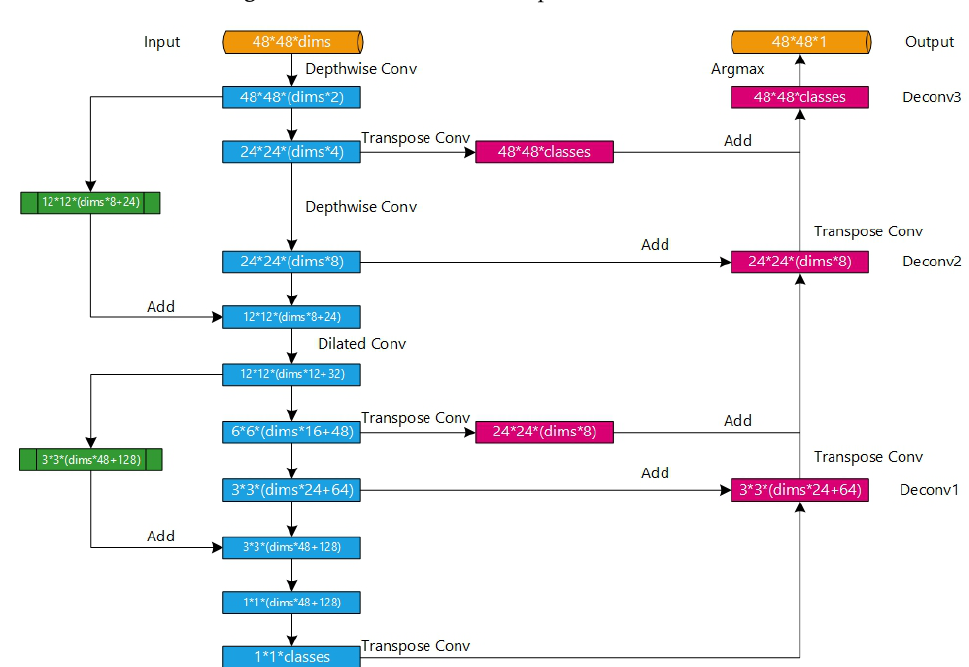
Figure 2. Structure of neural networks in our segmentation method. Blue and green blocks donate